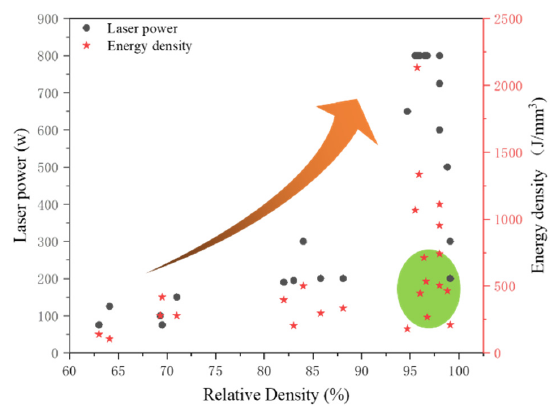
Figure 10. The relationship between laser power and relative density of pure copper part manufactured via SLM additive manufacturing [1,2,5,7,9,10,27,37,39,40–42,44].